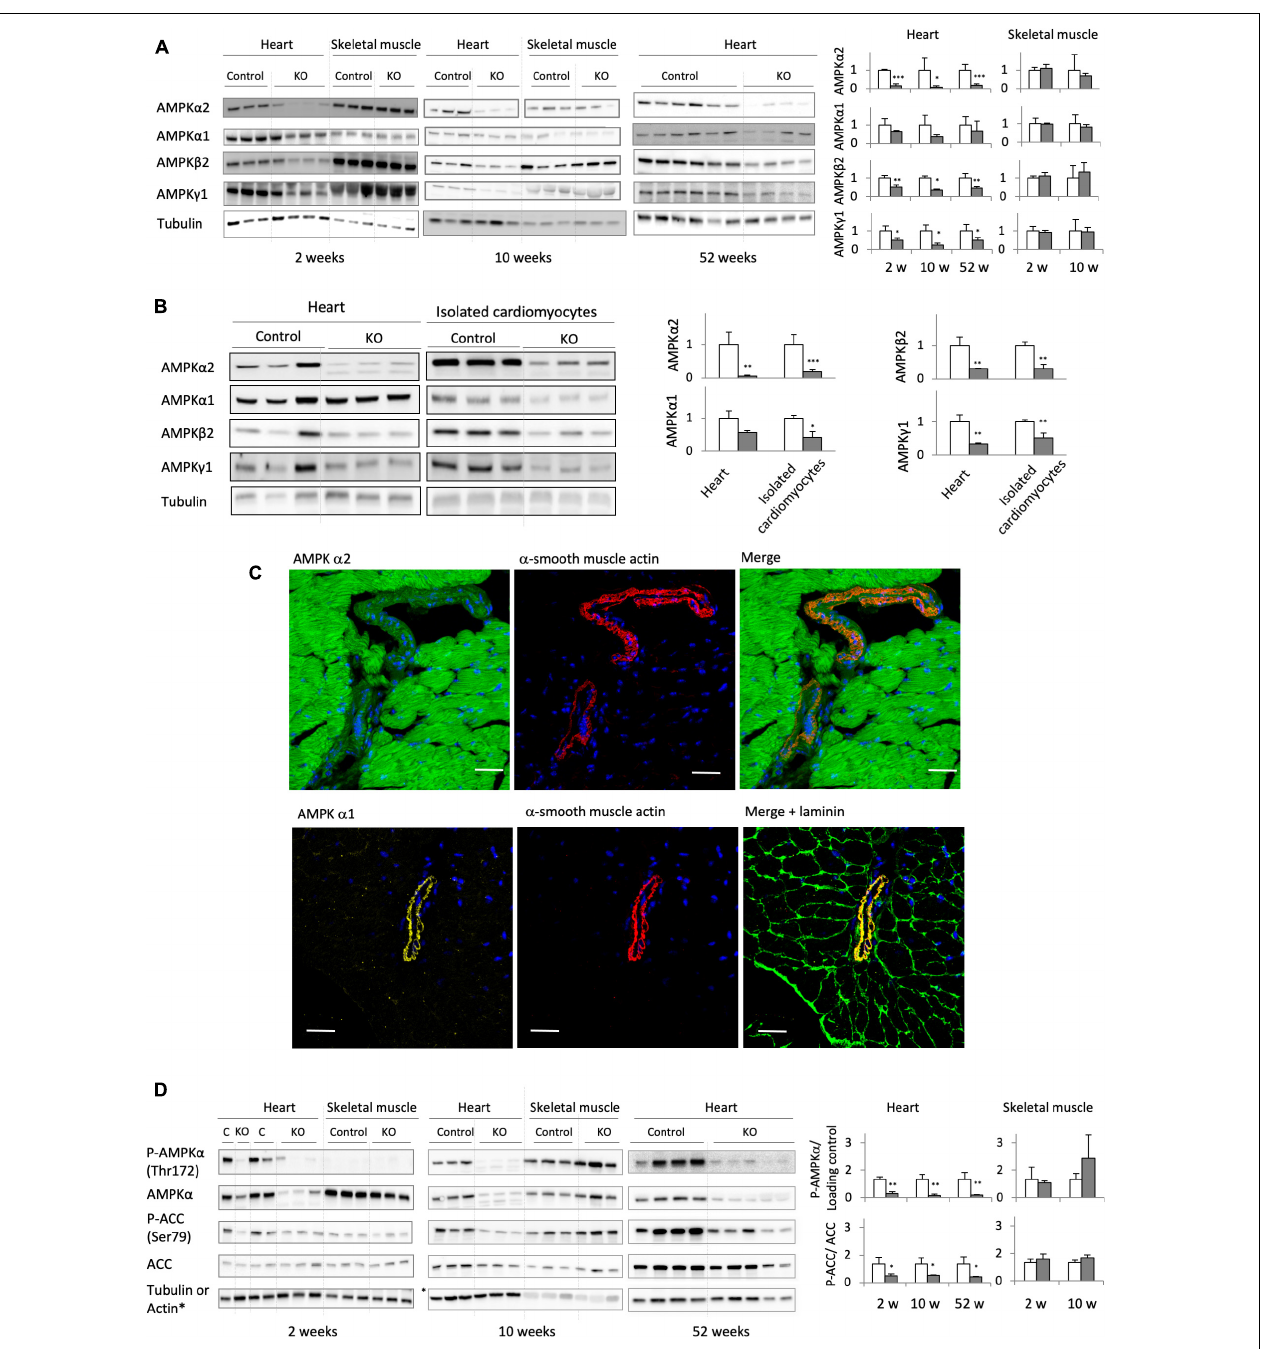
FIGURE 2 | Cardiomyocyte-specific AMPK α 1 and α 2 deletion. (A) Immunoblot analysis of the expression of AMPK subunits ( α 1, α 2, β 2, and γ 1) in total heart extract of control and AMPK α 1 α 2-KO mice 2, 10, and 52 weeks after tamoxifen administration; for comparison, the expression of AMPK subunits in skeletal muscles at 2 and 10 weeks is given. (B) Western blot detection of AMPK subunits in total heart and isolated cardiomyocytes from control and AMPK α 1 α 2-KO mice 6 weeks after tamoxifen administration. For each protein, signals for total heart and isolated cardiomyocytes originate from the same blot. (C) Distribution of AMPK α 1 and α 2 isoforms between cardiomyocytes and smooth muscle cells of blood vessels (stained with α -smooth muscle actin) studied by immunofluorescence in control heart sections. Laminin staining was used to visualize cell borders. Scale bar 30 µ m. As seen here, remnants of AMPK α 2 and mainly α 1 in AMPK α 1 α 2-KO total heart extract in panel (A) are likely due to the presence of non-cardiomyocyte cells in heart tissue. (D) Phosphorylation of AMPK α (Thr172) and ACC (Ser79) in total heart extracts of control and AMPK α 1 α 2-KO mice 2, 10, and 52 weeks after tamoxifen administration; for comparison, P-AMPK α and P-ACC in skeletal muscles at 2 and 10 weeks are given. For panels (A,B,D) : representative tubulin blots for each sample are shown, further loading controls are given in Supplementary Figure 2 ; band quantifications were corrected for loading (tubulin, actin or total protein); control (white bar, normalized to 1), KO (gray bar). Data are presented as means ± SD. ∗ p < 0.05, ∗∗ p < 0.01, ∗∗∗ p < 0.001 vs. control ( n ≥ 3) as determined by t -test.